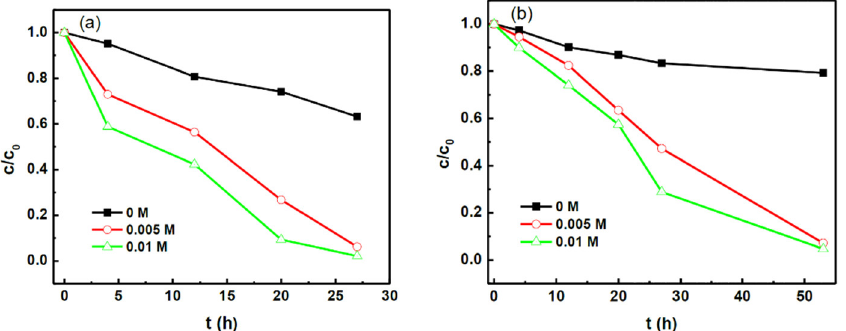
Figure 9. Effect of ionic strength on the sorption of positively charged AuNPs on pyrite ( a ) pH = 4.0; ( b ) pH = 7.1.